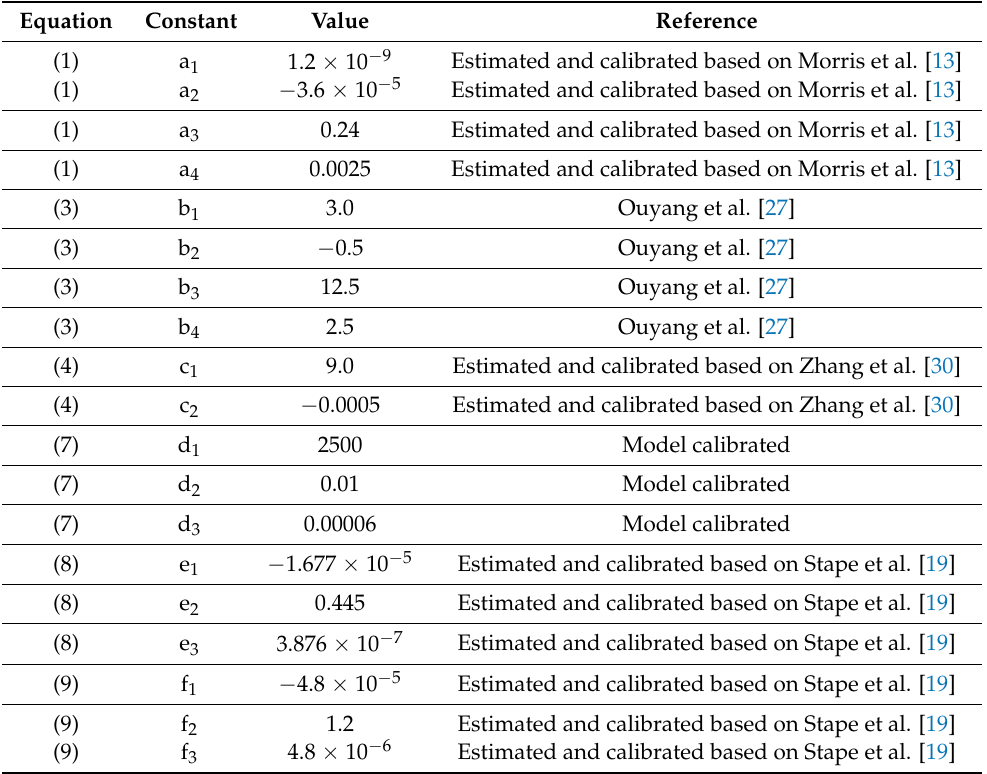
Table 1. Input values for the constants in the equations used in this